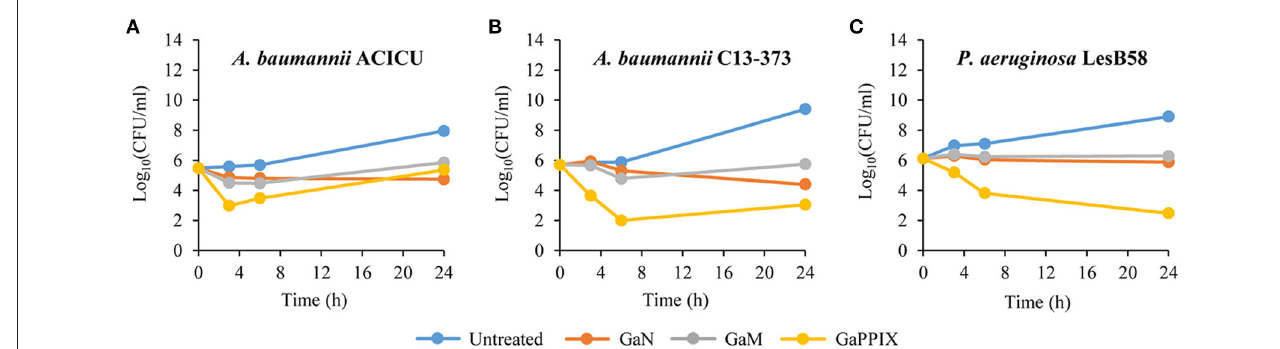
FIGURE 3 | Bactericidal activity of Ga(III) compounds on susceptible strains. GaN, GaM, and GaPPIX time-kill kinetics were determined by plate counts after 0-, 3-, 6-, and 24-h incubation in RPMI-HS supplemented with 28 µ M of each Ga(III) compound. (A) A. baumannii ACICU, (B) A. baumannii C13-373 and (C) P. aeruginosa LesB58. Panels show one representative experiment of three independent replicates yielding similar results.